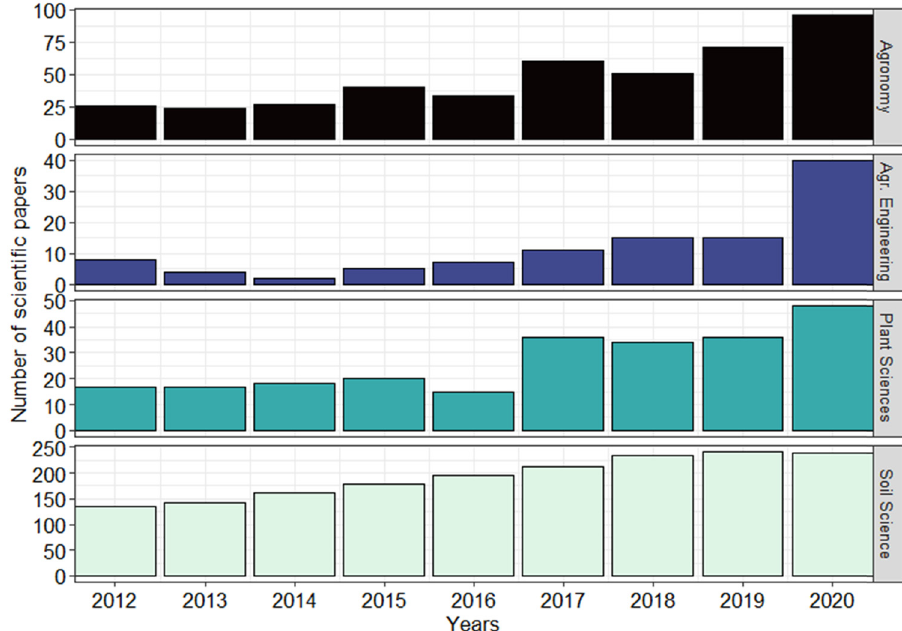
Figure 7: Publication records on general topics: soil science, plant science, agricultural engineering, and agronomy from 2012 to 2020 in Russia with foreign co - authorships. Source: Own calculation using R software 4.0.2 ( 2021 ) based on the data aggregated by the Clarivate Analytics, WoS Core Collection ( 2021 )